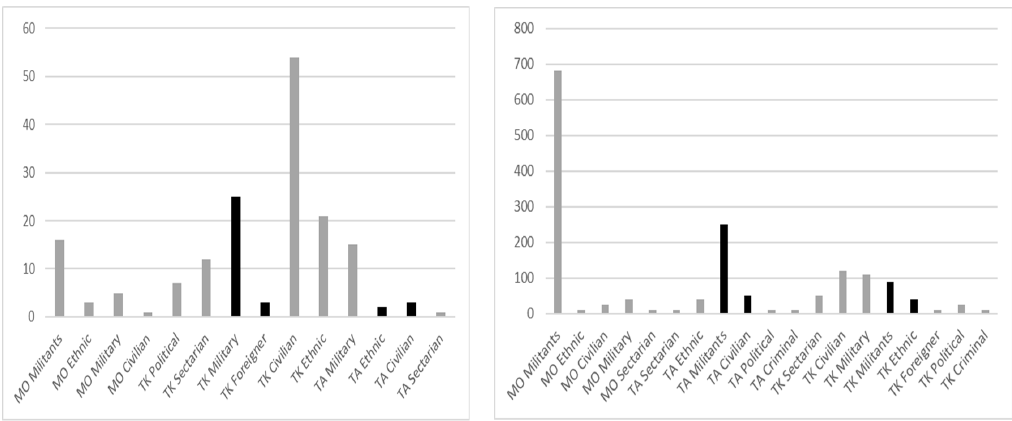
Figure 8. Cluster analysis for Balouchistan ( left ) and Khyber Pakhtunkhaa ( right ), collectively for all events, for the time period 1988–2012.